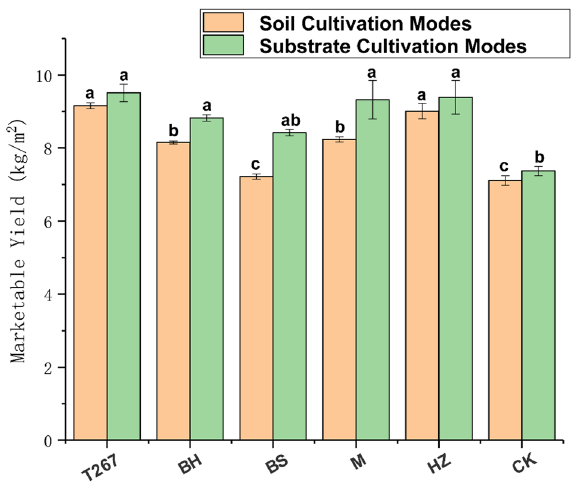
Figure 2. Effect of different biofertilizer treatments on the total marketable yield of cucumber. Means (N = 3) within the same time period accompanied by the same letter were not statistically different (P = 0.05), according to Duncan’s new Multiple-Range test. S267 = Trichoderma Strain 2 67 added to soil; SBH = Bacillus subtilis and T. harzianum biofertilizers added to soil; SBS = B. subtilis biofertilizer added to the soil; SM = Compound biofertilizer added to soil; SHZ = T. harzianum biofertilizer added to soil; SCK = Untreated soil. US267 = T. 267 biofertilizer added to substrate; USBH = B. subtilis and T. harzianum biofertilizers added to substrate; USBS = B. subtilis biofertilizer added to substrate; USM = Compound biofertilizer added to substrate; USHZ = T. harzianum biofertilizer added to substrate; USCK = Untreated